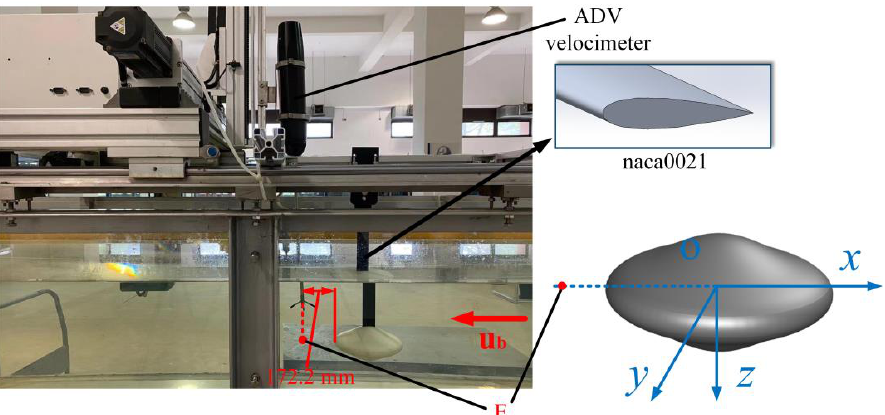
Figure 13. Schematic diagram of experimental system and the locations (E) for the flow velocity investigation close to the rear surface of the vessel.